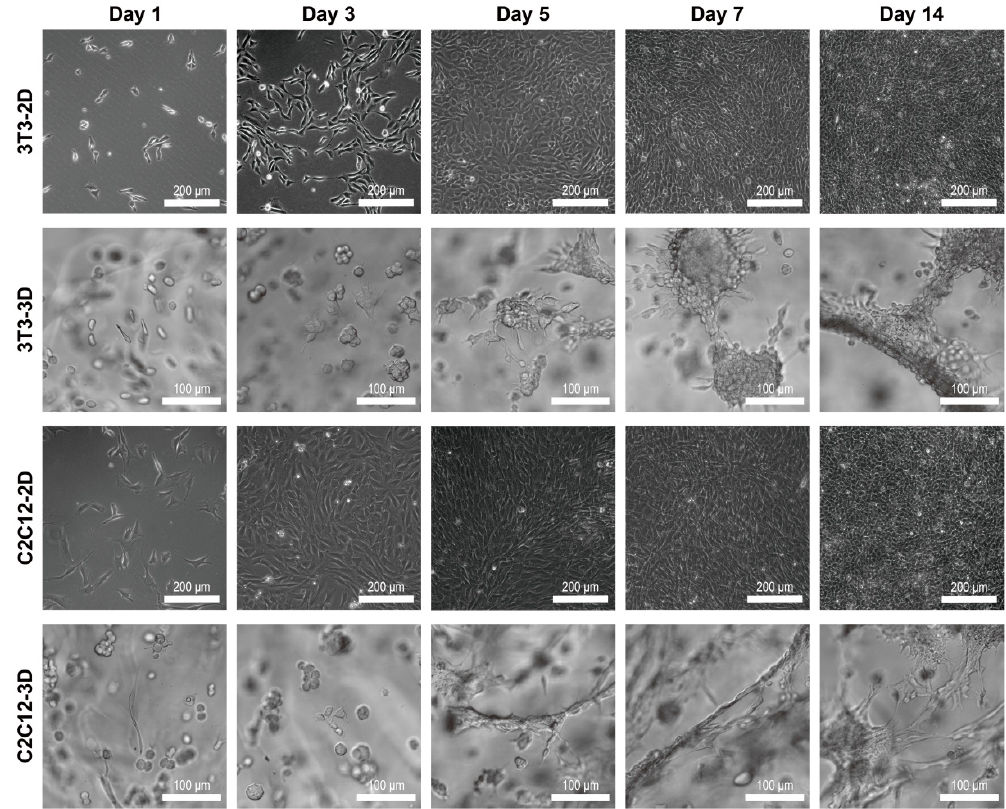
Figure 5. Bright-field images of 3T3 and C2C12 cells in a 2D petri dish and 3D RGD-homogenous dextran hydrogel from day 1 to day 14. The main parameters of dextran hydrogel were crosslinking strength = 2 mM and RGD = 300 µM.